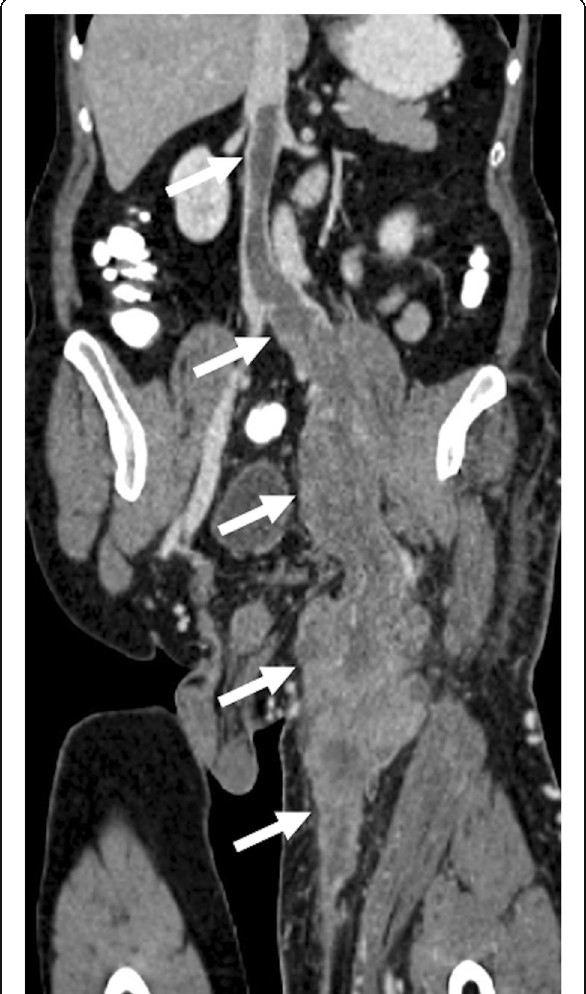
Fig. 19 A 65-year-old male with no significant past medical history presented with left lower extremity swelling and palpable groin mass. Coronally reformatted postcontrast CT image demonstrates heterogeneously enhancing solid mass extending along the left great saphenous vein. The mass extends cranially to the IVC via the femoral and iliac veins (arrows). Postsurgical histopathologic examination revealed leiomyosarcoma of the great saphenous